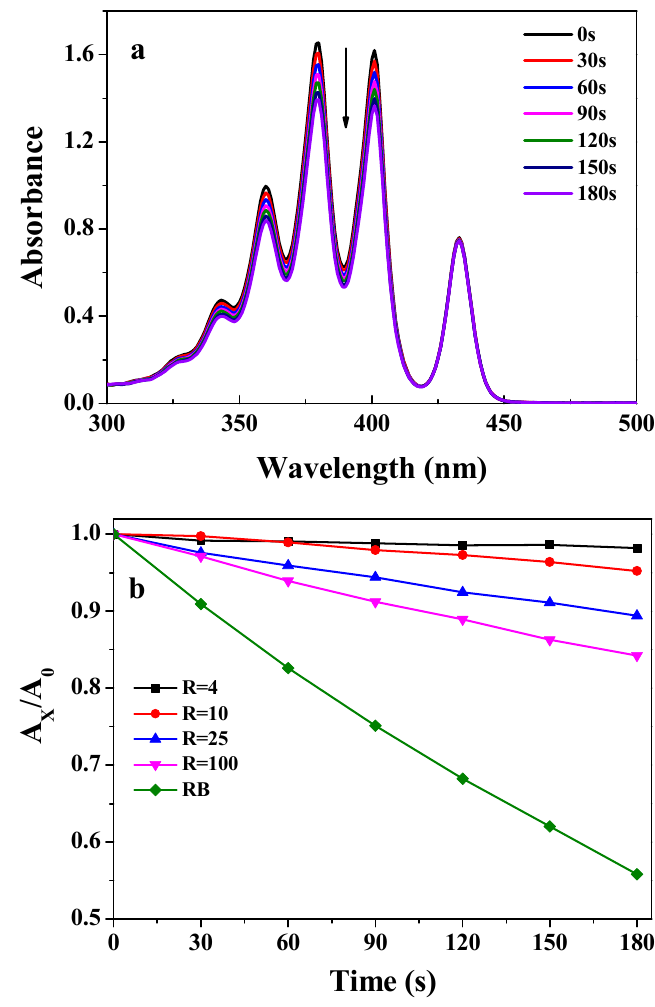
Figure 6. ( a ) Variation of the absorption spectrum of ABPA in the presence of complex micelle at R = 100. ( b ) Absorbance of ABDA at 380 nm as a function of irradiation time in the presence of the complex micelle with different R values and